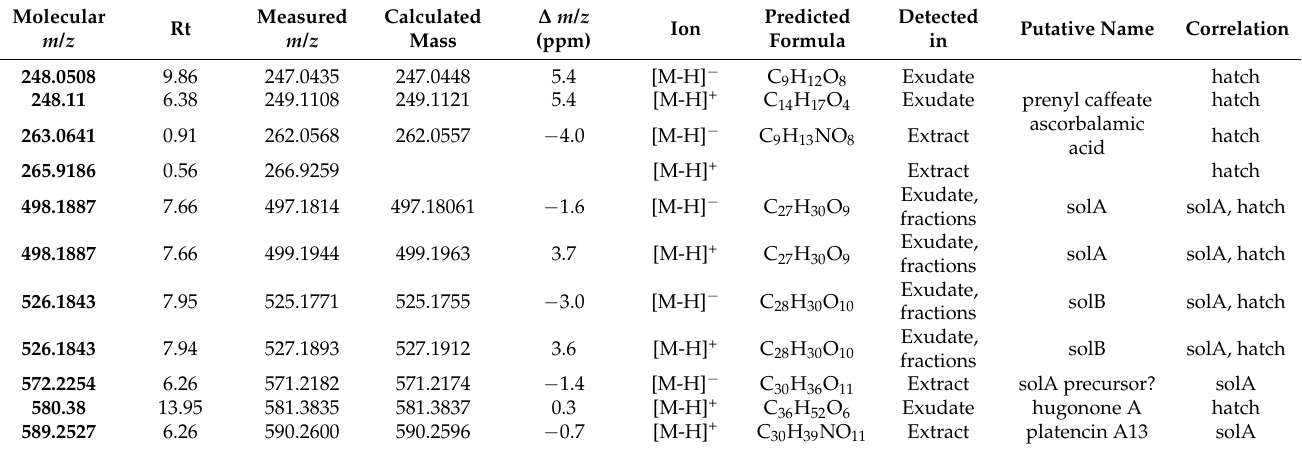
Table 1. Metabolites detected in root extract, exudates, and fractions of exudates that are of particular interest because of high correlation (RF and/or Pearson’s) with solA content of root exudates or PCN hatching. Molecular m / z is the theoretical mass to charge ratio, whereas measured m / z is the detected mass to charge ratio under positive or negative ionization modes. SolA and solB were both detected under both positive and negative ionization modes. ∆ m/z (ppm) is calculated by